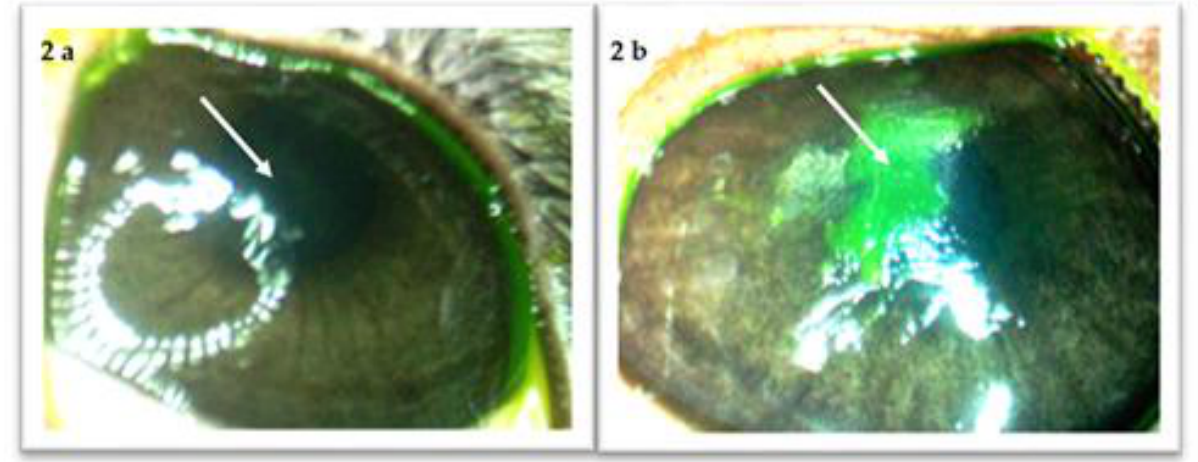
Figure 2. Postoperative day 7 control. ( a ) Cornea treated with SafeCross ® ; ( b ) Positive fluorescence staining in cornea treated with riboflavin + 0.10% EDTA.